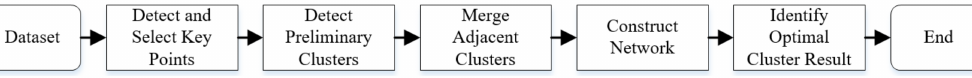
Figure 1. Logical flow of the proposed clustering method.